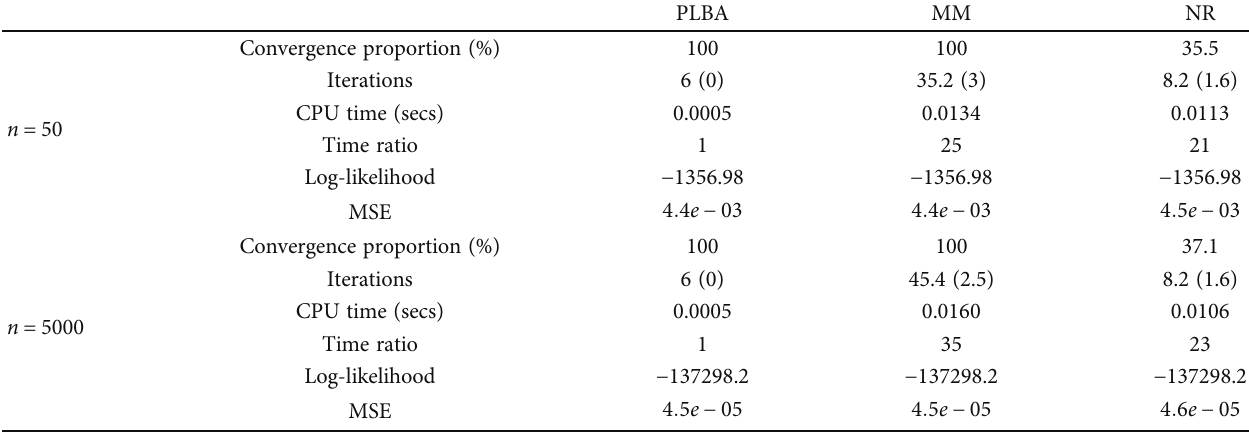
Table 4: Results for Scenario 3 (values in brackets are standard deviations).